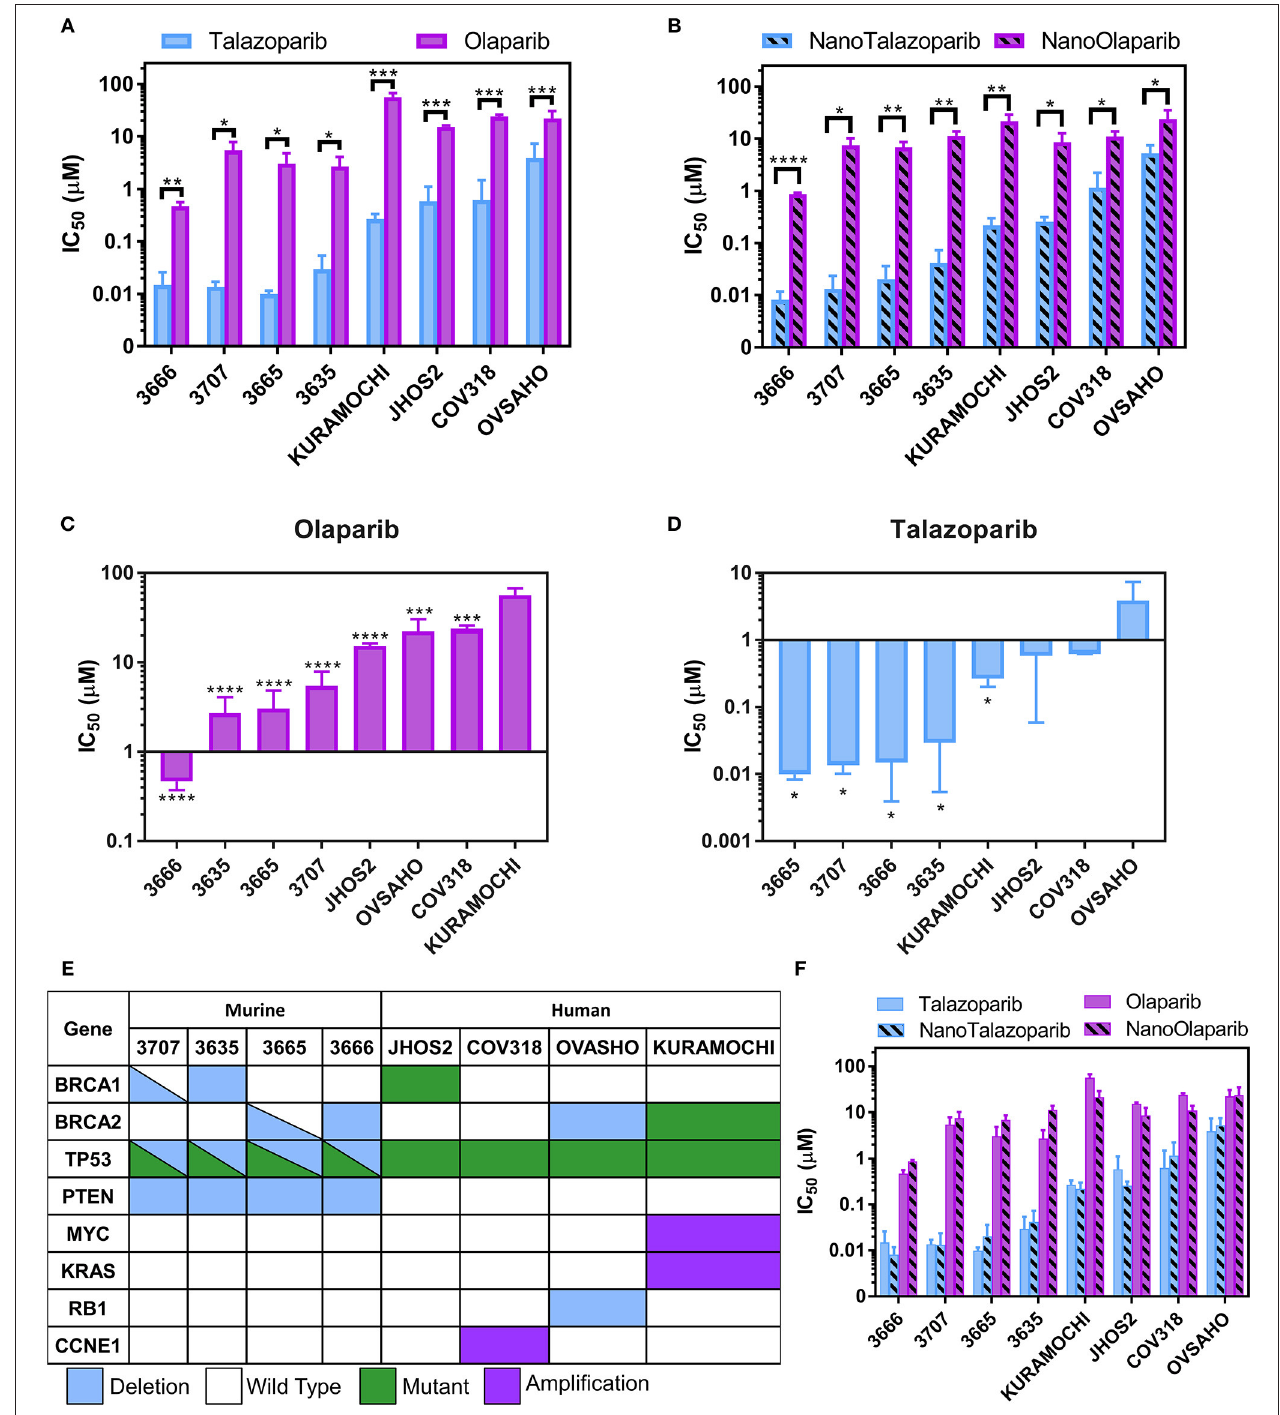
FIGURE 2 | IC50 values for a panel of 4 murine FT lines and 4 human HGSOC lines treated with (A) free Olaparib or Talazoparib and (B) NanoOlaparib and NanoTalazoparib. KURAMOCHI was the least sensitive line to Olaparib (C) while OVSAHO was the least sensitive to Talazoparib (D) . Description of (E) mutations and deletions of interest in the 8 cell lines tested. Comparison of all treatments in all cell lines (F) reveals no difference in free vs. nanoformulations. All experiments were performed in triplicate. Statistical significance between two treatments in a single line was tested with Student’s t -tests. Significance between lines was analyzed using one-way ANOVA followed by Tukey’s test for significance, * p < 0.05, ** p < 0.01, *** p < 0.001, **** p < 0.0001.